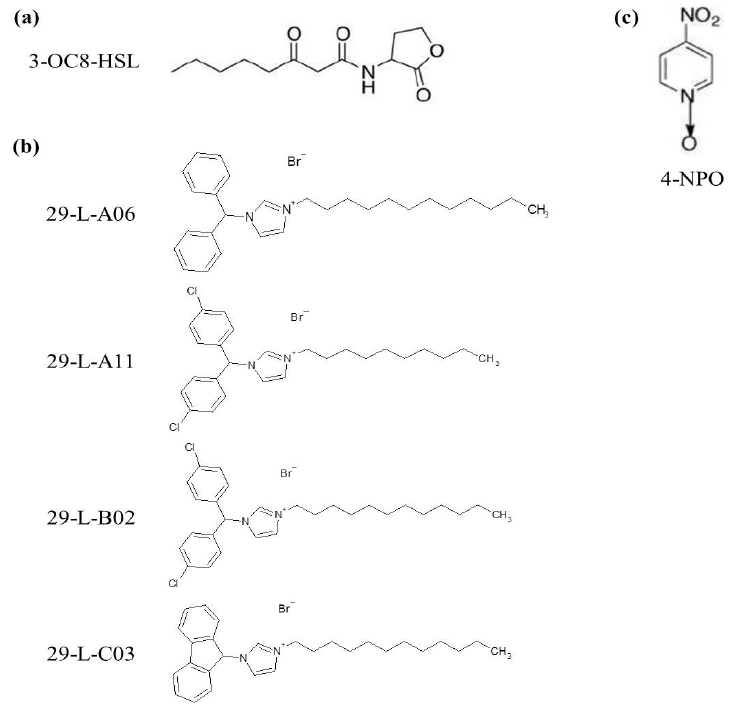
Figure 1. Structure of the used quorum sensing (QS)-molecule and identified quorum sensing-inhibitors (QSIs). ( a ) The 3-OC8-HSL is the N -acyl homoserine lactone (AHL) used as the QS-signal. ( b ) Structure of the identified QSIs. ( c ) 4-NPO, used as a QSI